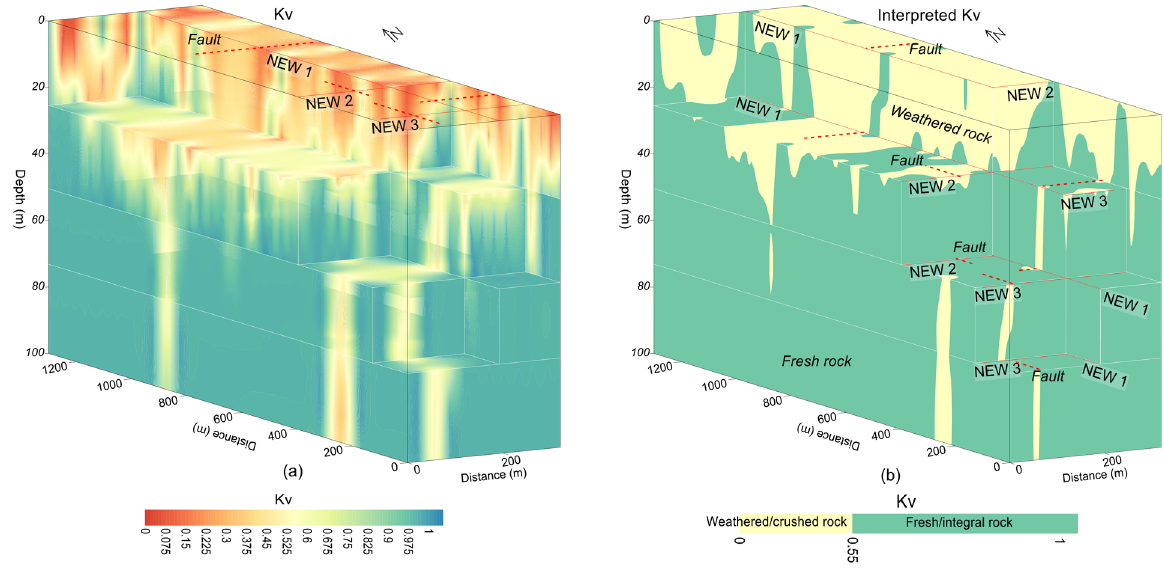
Figure 13. ( a ) Kv imaging (increasing from red to blue on a color scale) along three profiles (red lines) in various dimensions including faults (dotted red lines), and ( b ) Interpretation of a for the weathered/crushed rock (yellow color) and integral/fresh rock (green